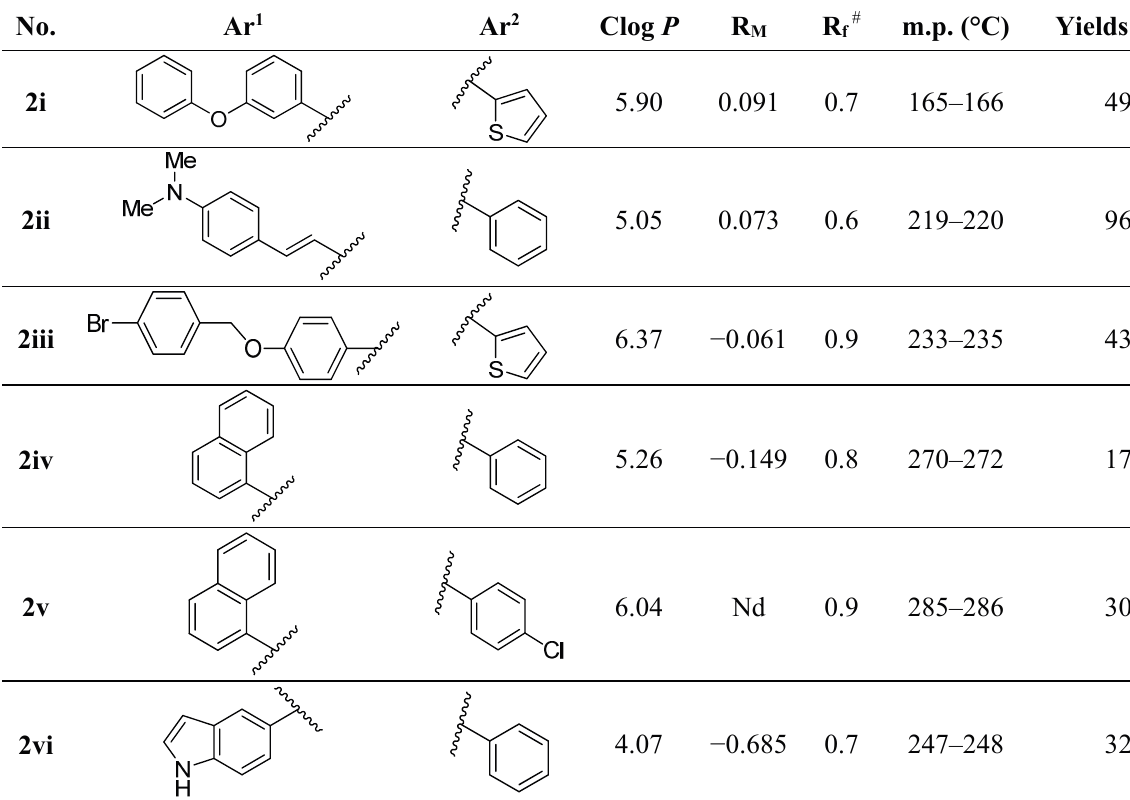
Table 2. Chemical structures, physicochemical and reaction data of pyrrole derivatives 2i – 2vi . No.